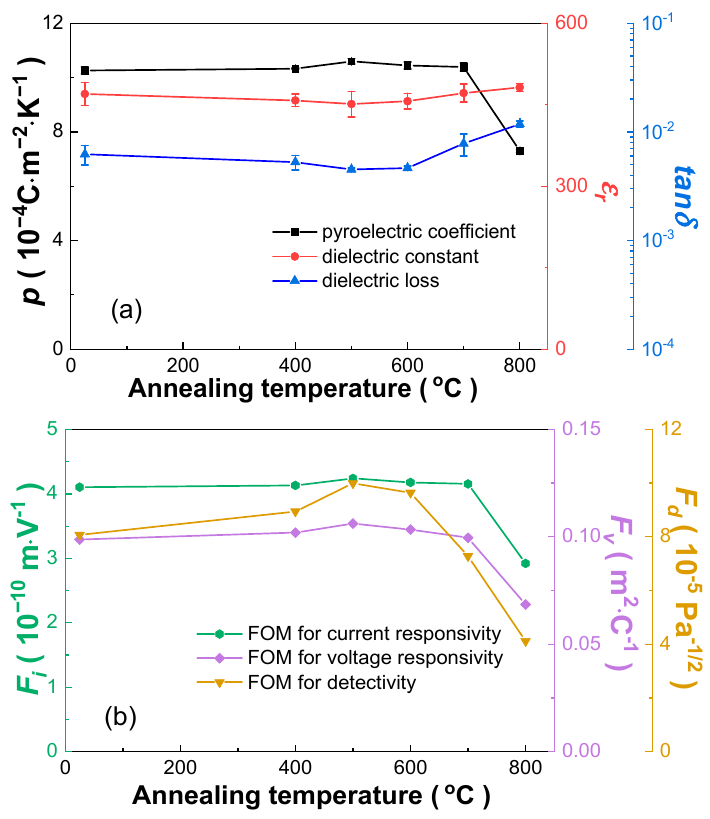
Figure 7. Room temperature-measured pyroelectric and dielectric properties versus annealing temperature of the thin Mn:PIMNT pyroelectric chips. ( a ) p , ε r and tan δ ; ( b ) F i , F v and F d .